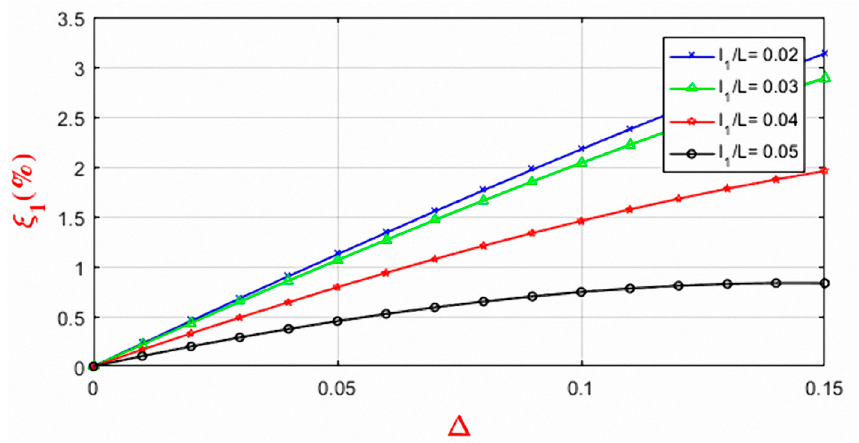
Figure 10. Relationship between Δ and ξ 1 % with different l 1 / L .